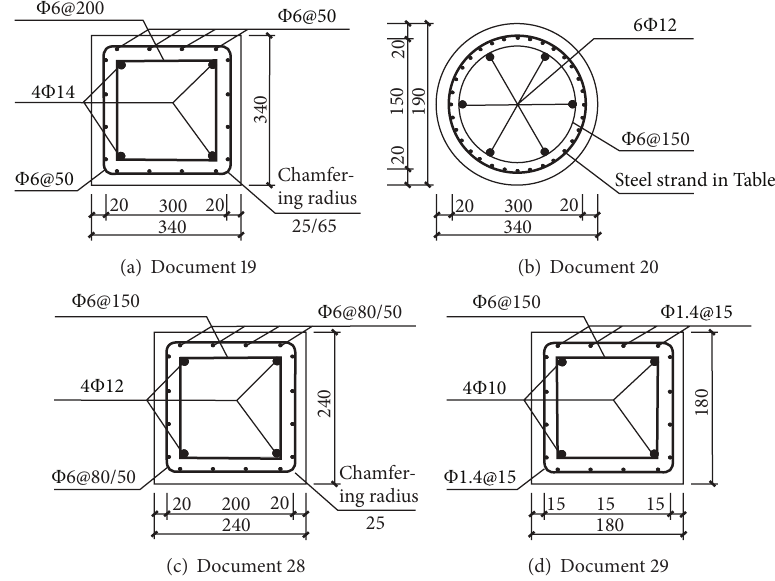
Figure 7: Cross sections of the strengthened